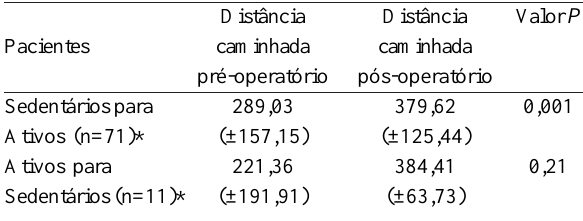
Tabela 3. Distância caminhada em metros no pré e pós-operatórios dos grupos ativo e sedentário que mudaram seus hábitos.